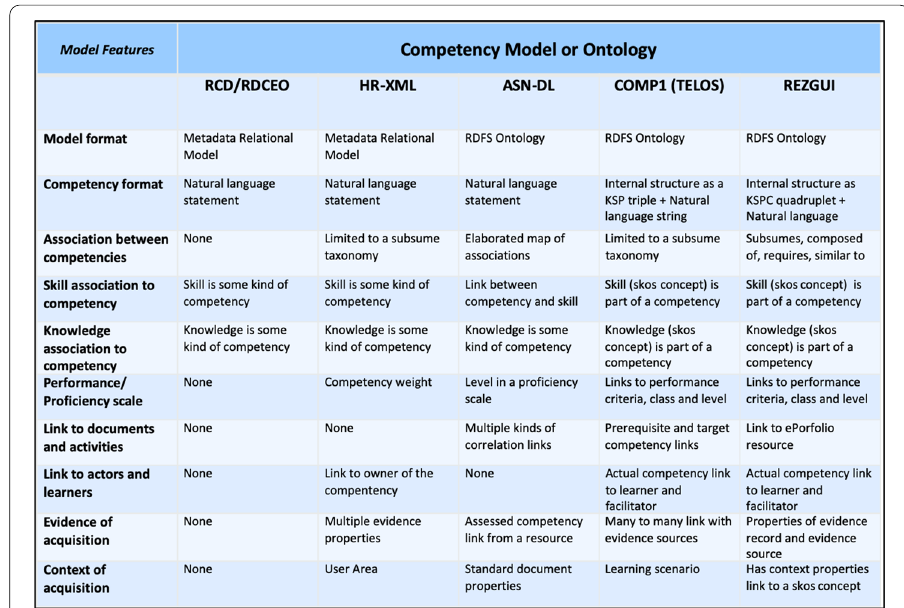
Fig. 2 Competency ontology